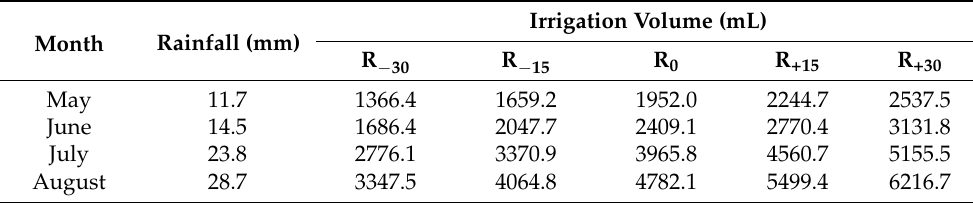
Table 1. Average monthly rainfall from May to August during the period of 1961 to 2018 and irrigation volume in the present